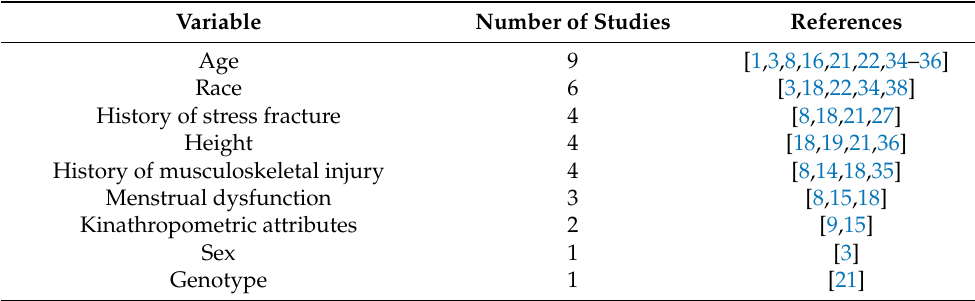
Table 3. Non-modifiable factors investigated for their associations with stress fracture